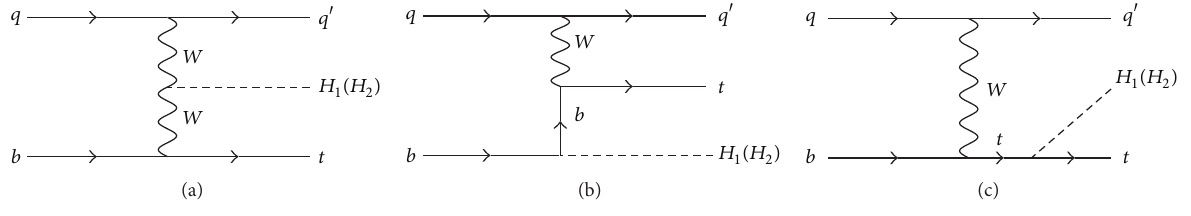
Figure 1: Lowest-order Feynman diagrams for 𝑝𝑝 → 𝑡𝐻 1 (𝐻 2 )𝑗 in the 𝑈(1) 𝐵